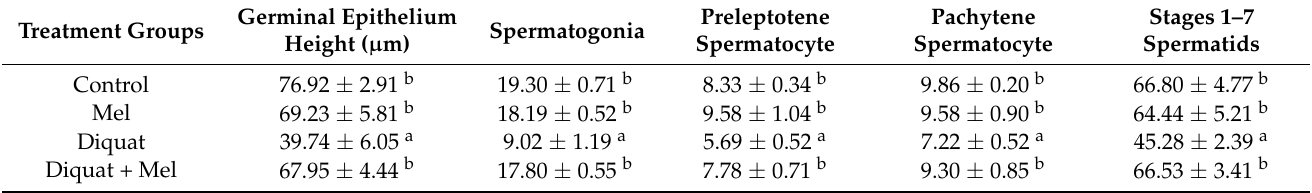
Table 1. Melatonin ameliorates thinness of seminiferous epithelium and loss of germ cells induced by diquat in